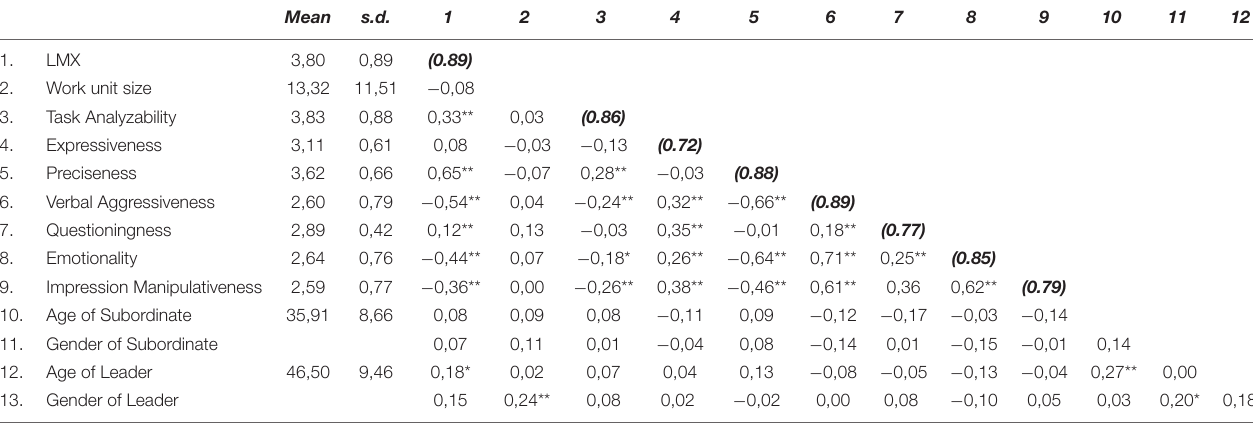
TABLE 2 | Descriptive Statistics, Correlations, and